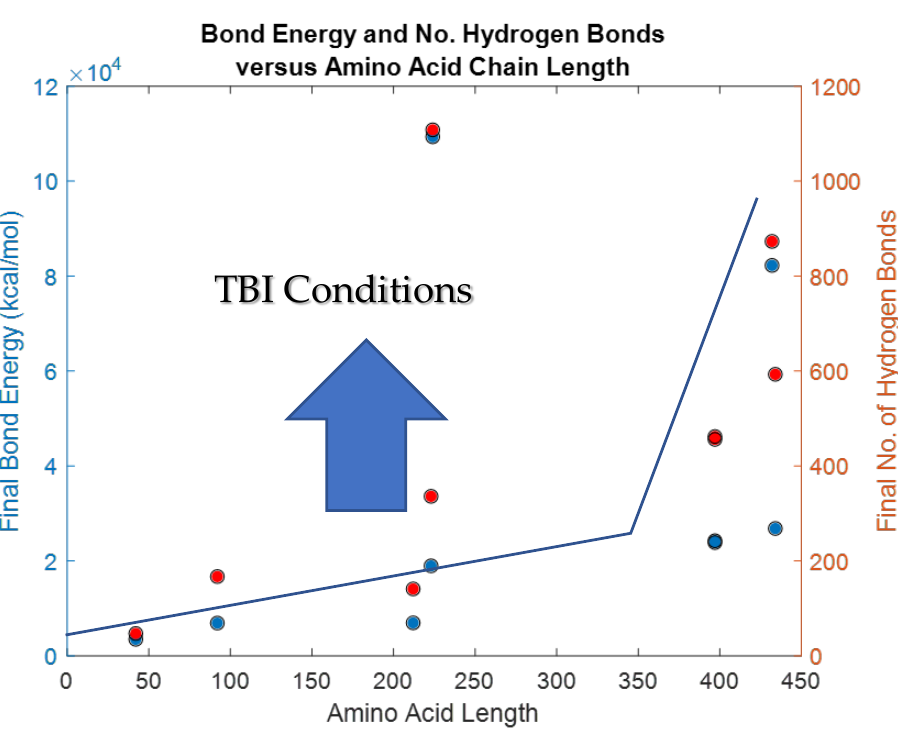
Figure 46. For a given time of dynamic simulation, bond energy and number of hydrogen bonds formed by the proteins with different amino acid length may indicate biomarker viability in diagnosis, blue line showing lower bound region where biochemical reactions stop.